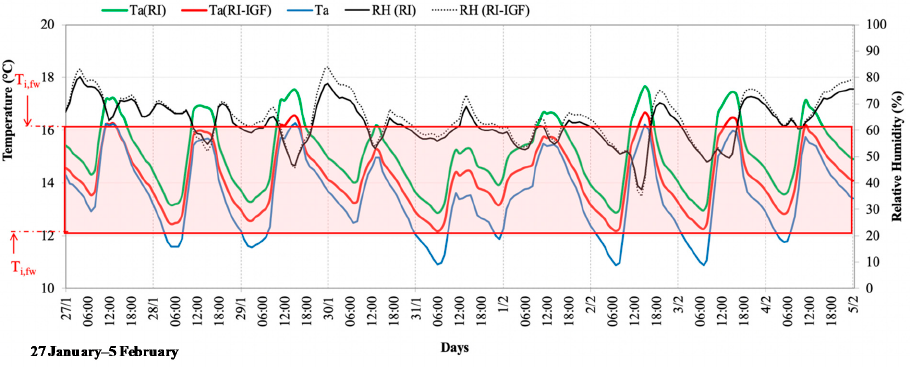
Figure 8. Daily profile of air temperature (T a ) in the current state, after retrofit Ta (RI), and retrofit scenario with uninsulated floor on ground surface (RI-IGF) during the period 27 January–5 February. Energies 2020 , 13 , x FOR PEER REVIEW Table 7. Maximum and minimum values of air temperature, maximum amplitude of temperature, and relative humidity of the three investigated scenarios during period 27 January–5 February.